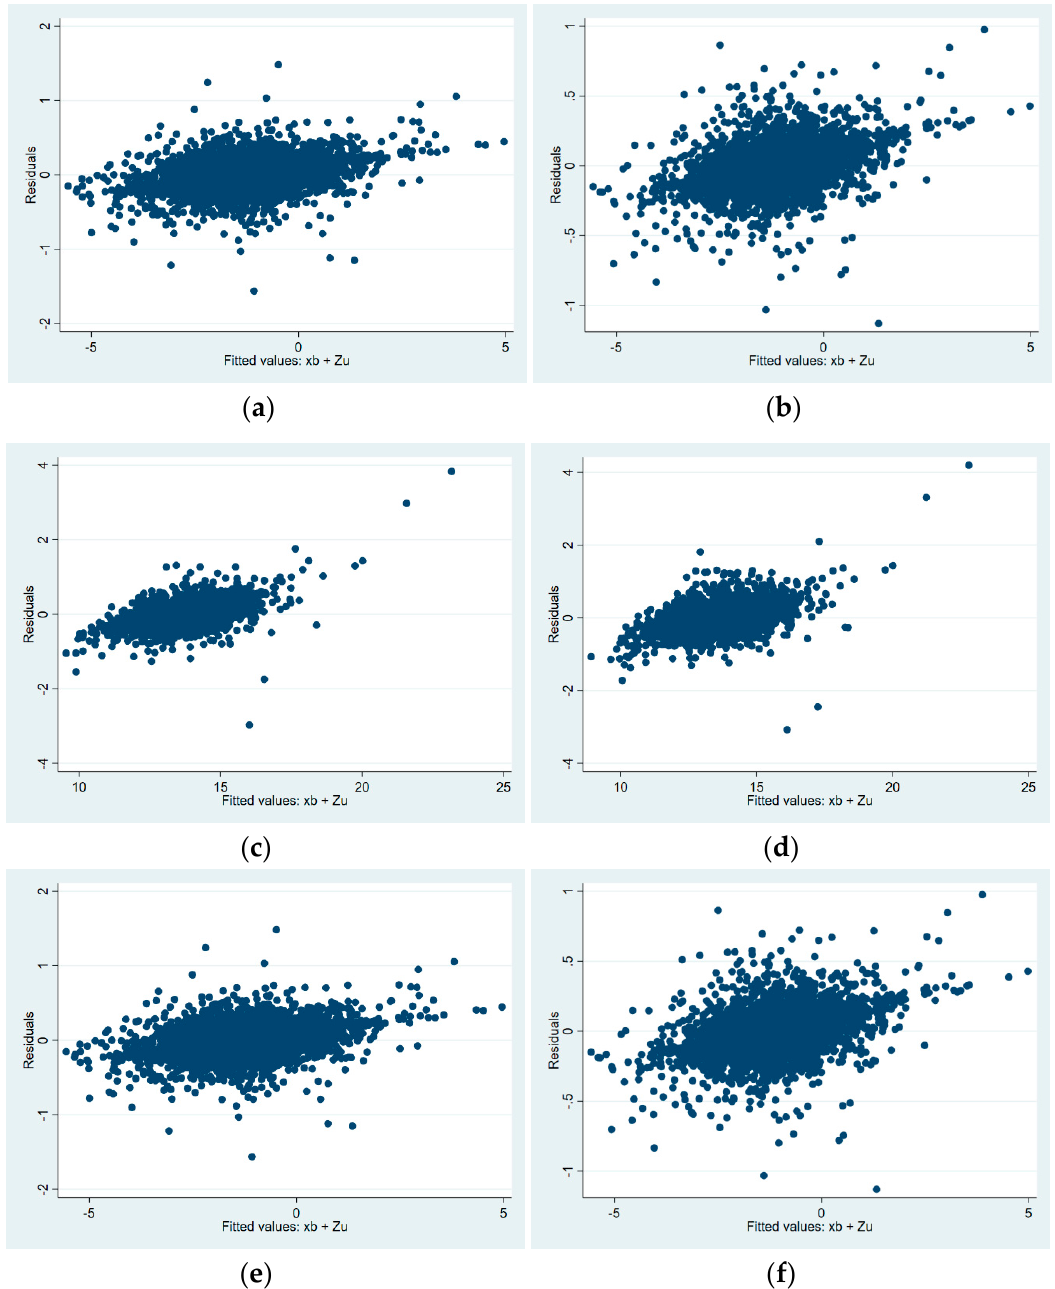
Figure 1. Model diagnosis for the six full adjusted models. Plot of the residuals against the linear prediction from fixed plus random effects values for WHZ_JMP-CS ( a ) and National-CS ( b ) composite score, MUAC_JMP-CS ( c ) and National-CS ( d ) composite score and HAZ_JMP-CS ( e ) and National-CS ( f ) composite score.